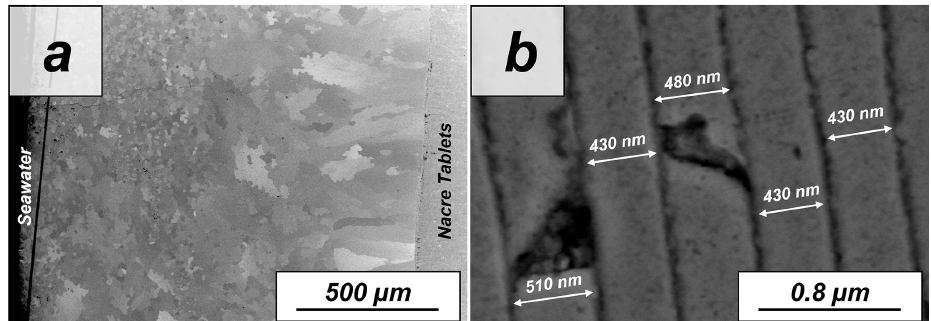
Figure A9. FE-SEM images showing the (a) prismatic and (b) nacreous layers of the shell of the gastropod Haliotis ovina . (a) Aragonitic prisms which build the outer layer of the shell are not similar in size. Small prisms form the outermost shell layers, while large prisms accumulate at the transition to the nacreous shell portion. (a, b) Aragonitic nacre tablet assemblies are next to the soft tissue of the animal. The tablets have a width in cross section between 400 and 500nm.